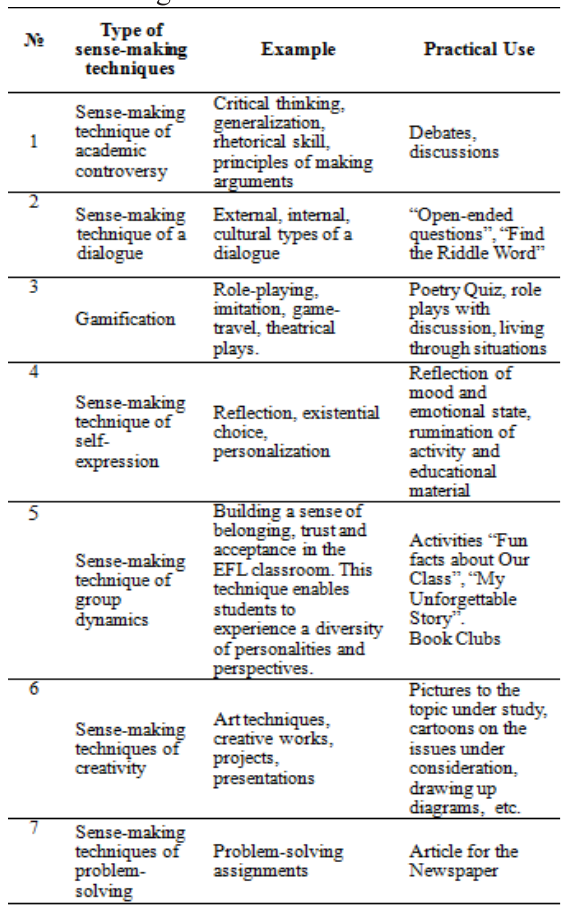
Table 1. Sense-making techniques in EFL meaning-centered